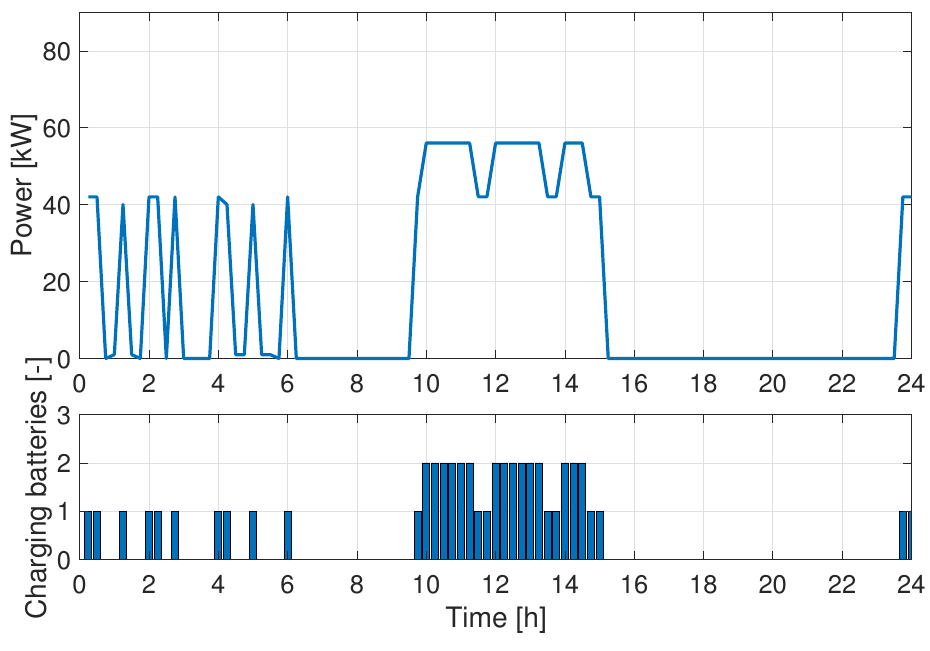
Figure 6. Power consumption (top) and battery charging schedule (bottom) at LIMB for the Most Demanding Day